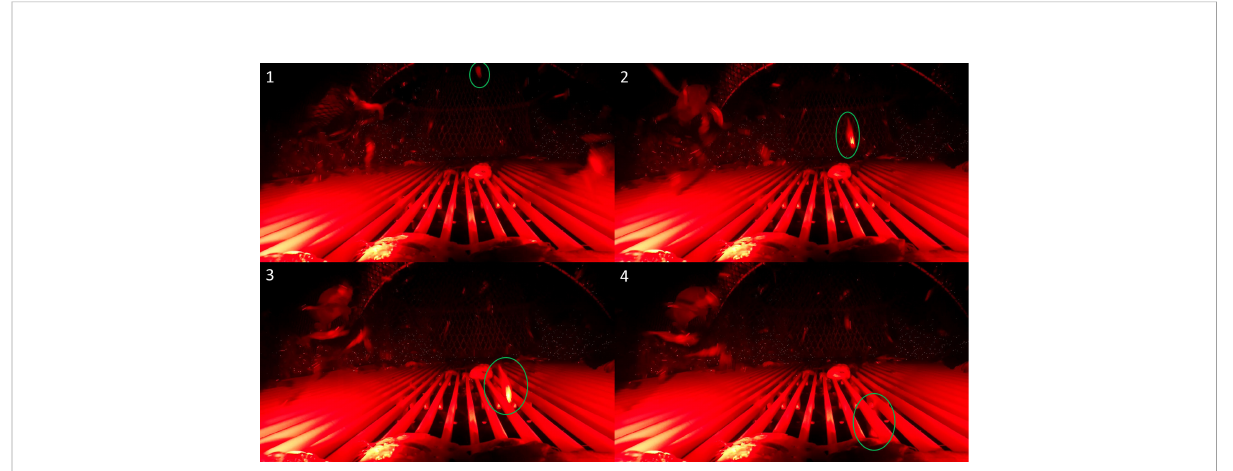
FIGURE 7 A behavioral sequence leading to retention. Underwater video screenshot of a red fi sh that exhibited towards body orientation (1), upwards approach (2), contacted the grid (3), continued swimming towards the grid, passed through the grid bar spacings, and was retained